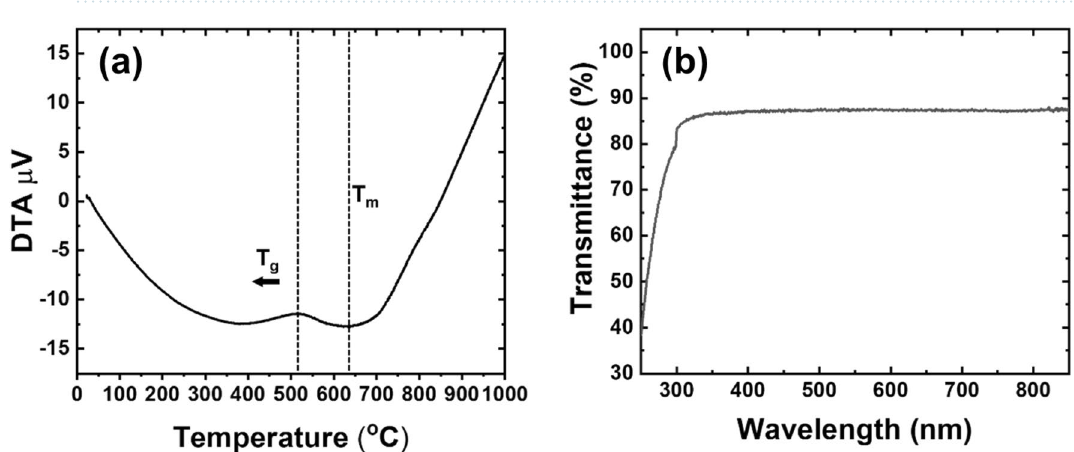
Figure 5. ( a ) DSC analysis result of glass frit. ( b ) Transmittance of fabricated glass